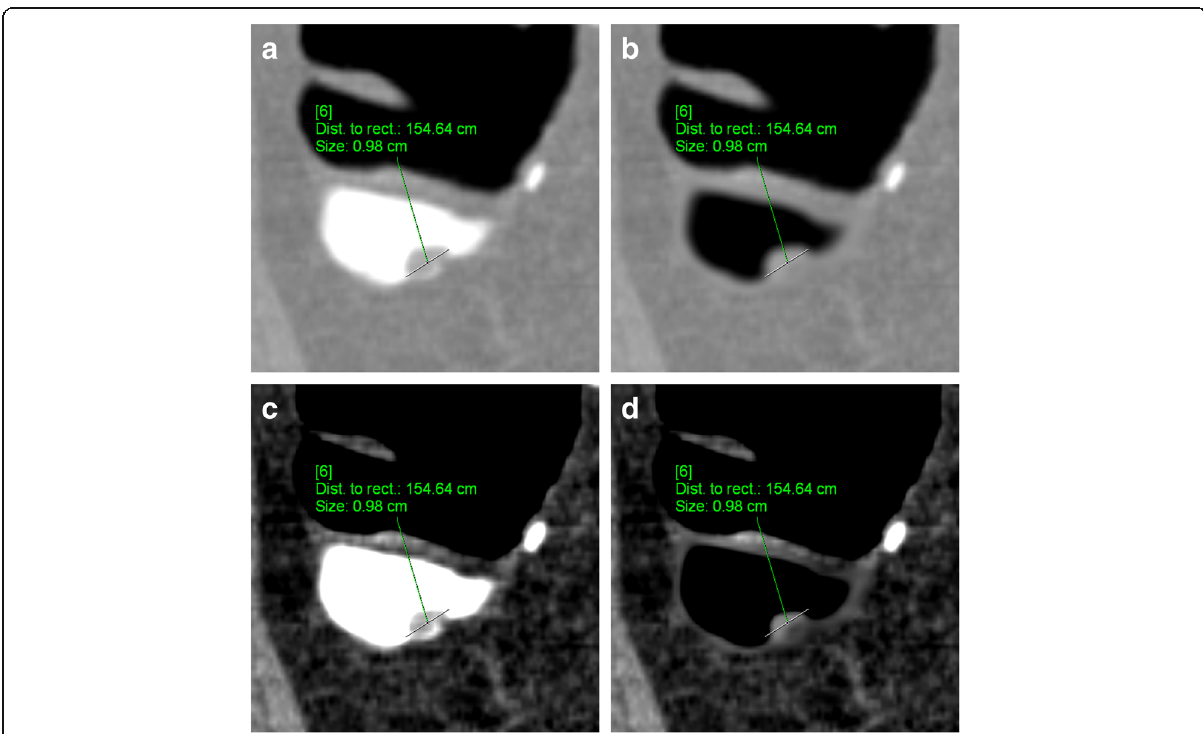
Fig. 10 Apparent size reduction of a 10-mm submerged pedunculated polyp, located in the ascending colon, due to EC. a The size of the polyp is largest in the unsubtracted colon window (9.8 mm). b After EC, the polyp ’ s size decreased to 9.5 mm. c , d In the soft tissue window, the polyp size decreased from 7.0 mm before EC to 6.4 mm after